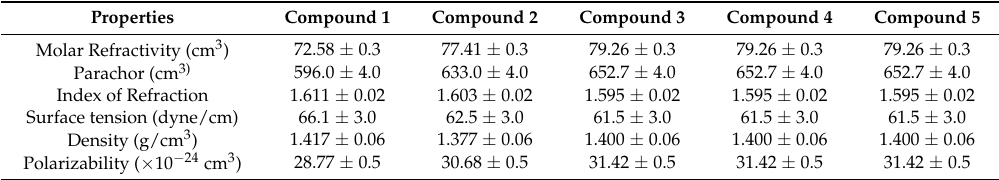
Table 2. Physicochemical characterization of iminodiacetic acid